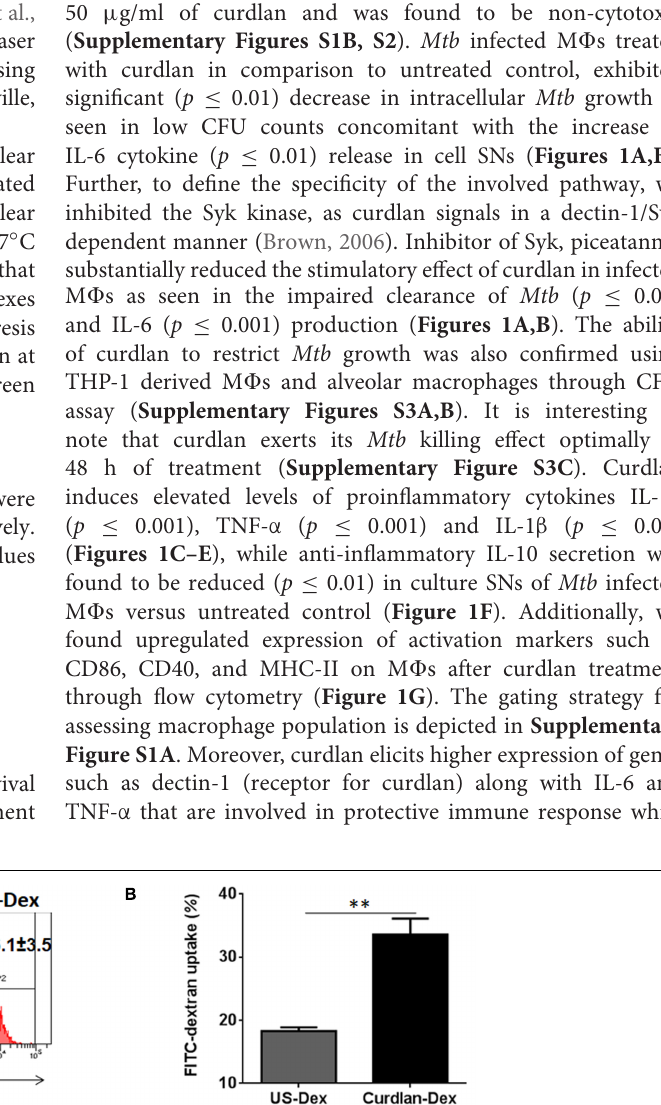
Frontiers in Microbiology |